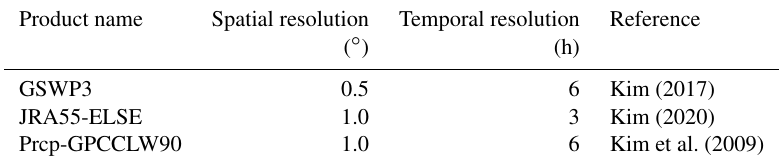
Table 4. Summary of meteorological forcing data used in this